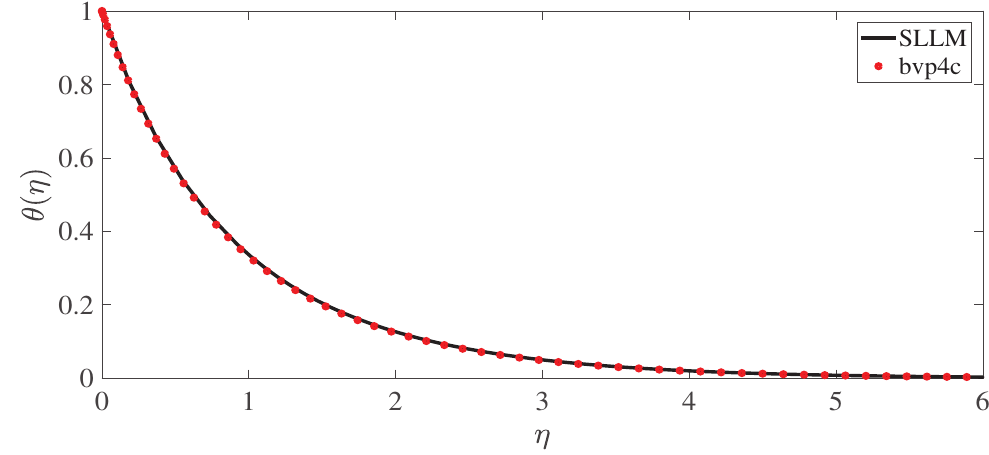
Figure 2. Solution comparison of bvp4c and SLLM approach for temperature